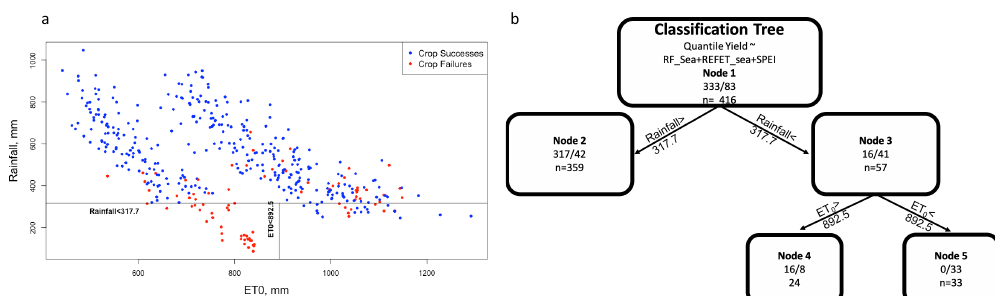
Figure 13. ( a ) The precipitation plotted against the ET 0 , with the rules of the classification tree shown as lines. The first rule is precipitation is greater (less) than 317.7 mm, the next split is ET 0 is greater (less) than 892.5 mm. Crop failures are shown in red, and crop successes as defined by the 20th quantile are shown in blue. ( b ) the classification tree is shown, with 416 observations, 83 of which are crop failures. In Node 2, the precipitation is greater than 317.7 mm, with 317 of the 359 observations being crop successes (88%) and 42 of the observations being crop failures (12%). In Node 3, the observations have less than 317.7 mm of precipitation, resulting in 16 crop successes of the 57 observations (28%) and 41 crop failures (72%). Node 4 has ET 0 less than 892.5 mm, and of the 24 observations, 16 are crop successes (66.7%) and 8 are crop failures (33.3%). Finally, Node 5 has ET 0 less than 892.5 mm and has 33 observations, all of which are crop failures